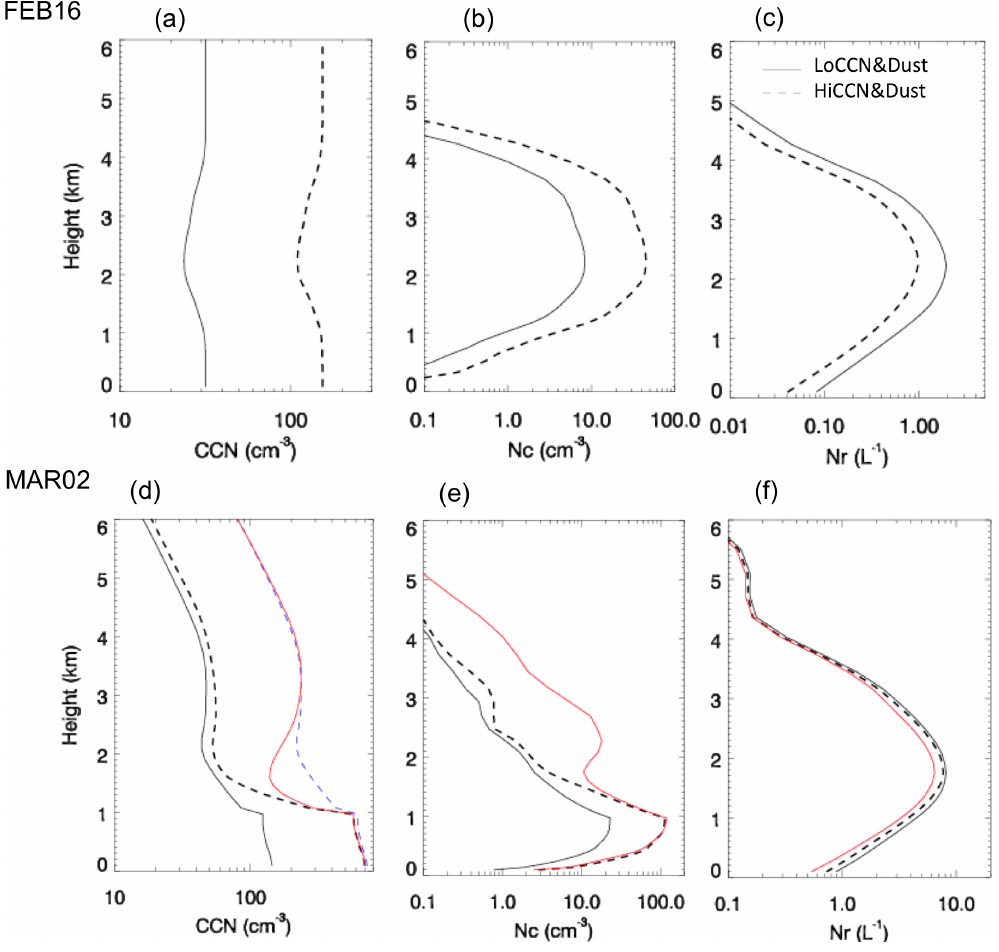
Fig. 12. Vertical profiles of CCN, N c , and N r from LoCCN&Dust (black solid line) and HiCCN&Dust (black dashed line) for FEB16 (a, b, c) and MAR02 (d, e, f) . The red line denotes a sensitivity run that is based on HiCCN&Dust but with polluted CCN concentrations at the southern and western boundaries. The data are averaged over the regions where the elevated CCN are applied in HiCCN&Dust (i.e., land with sea levels <200 m) during 00:00–23:00UTC. The dashed blue line in (d) for MAR02 denotes the increase of CCN from base-run conditions (black line) by 5